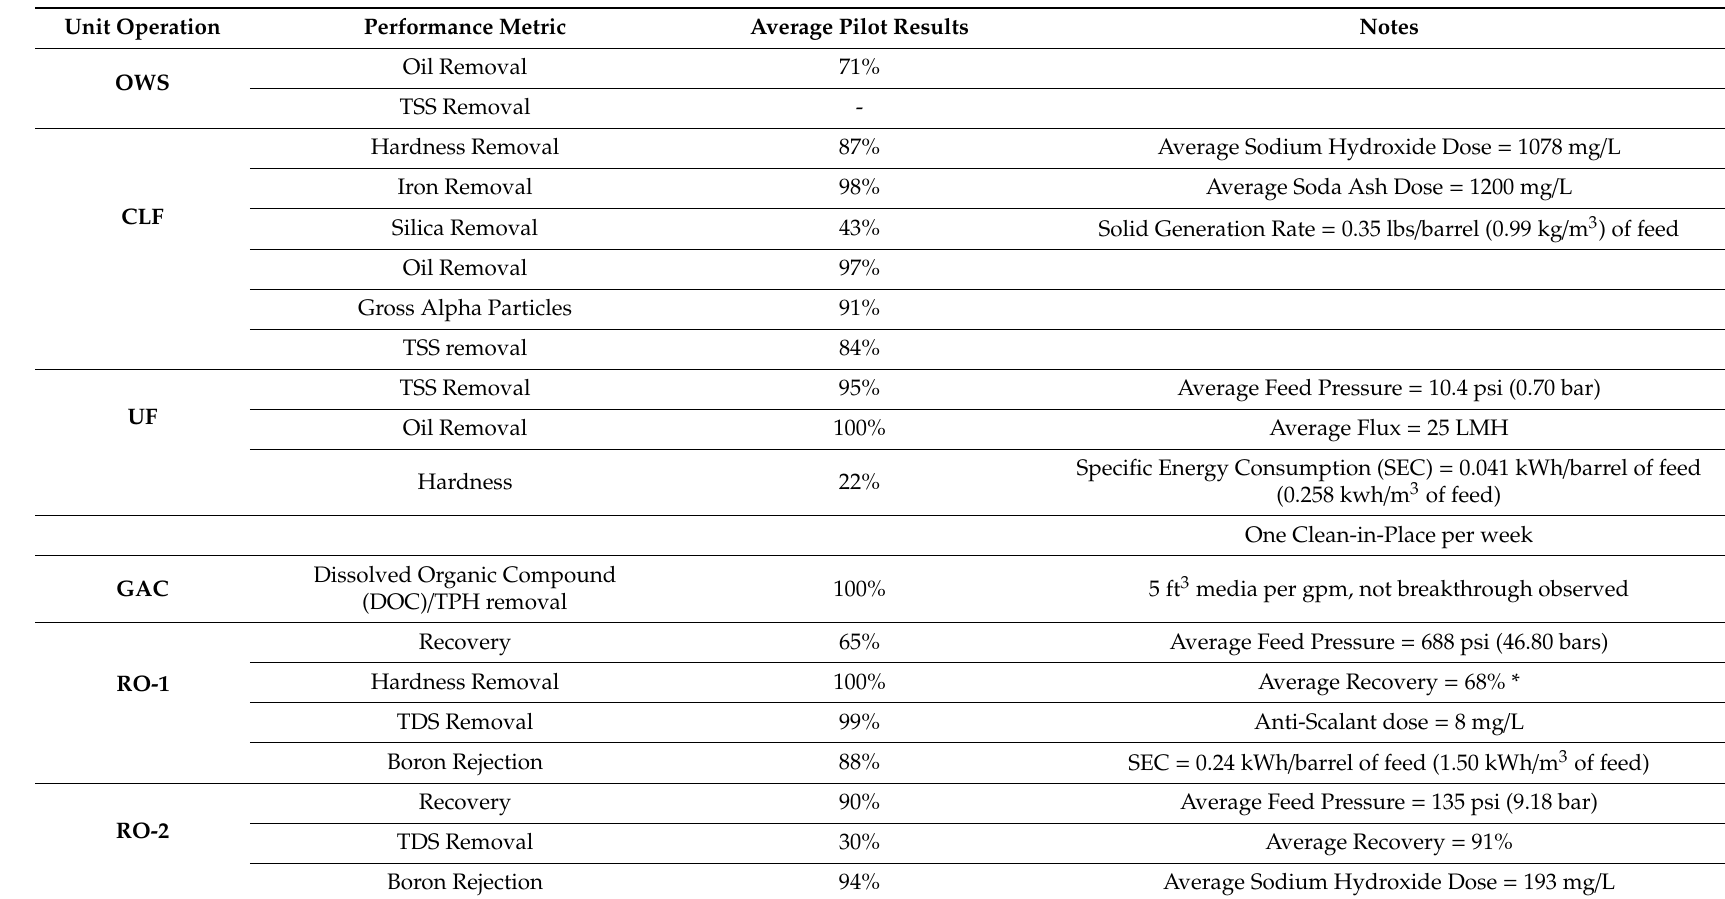
Table 8. Summary of unit operations performances and key process